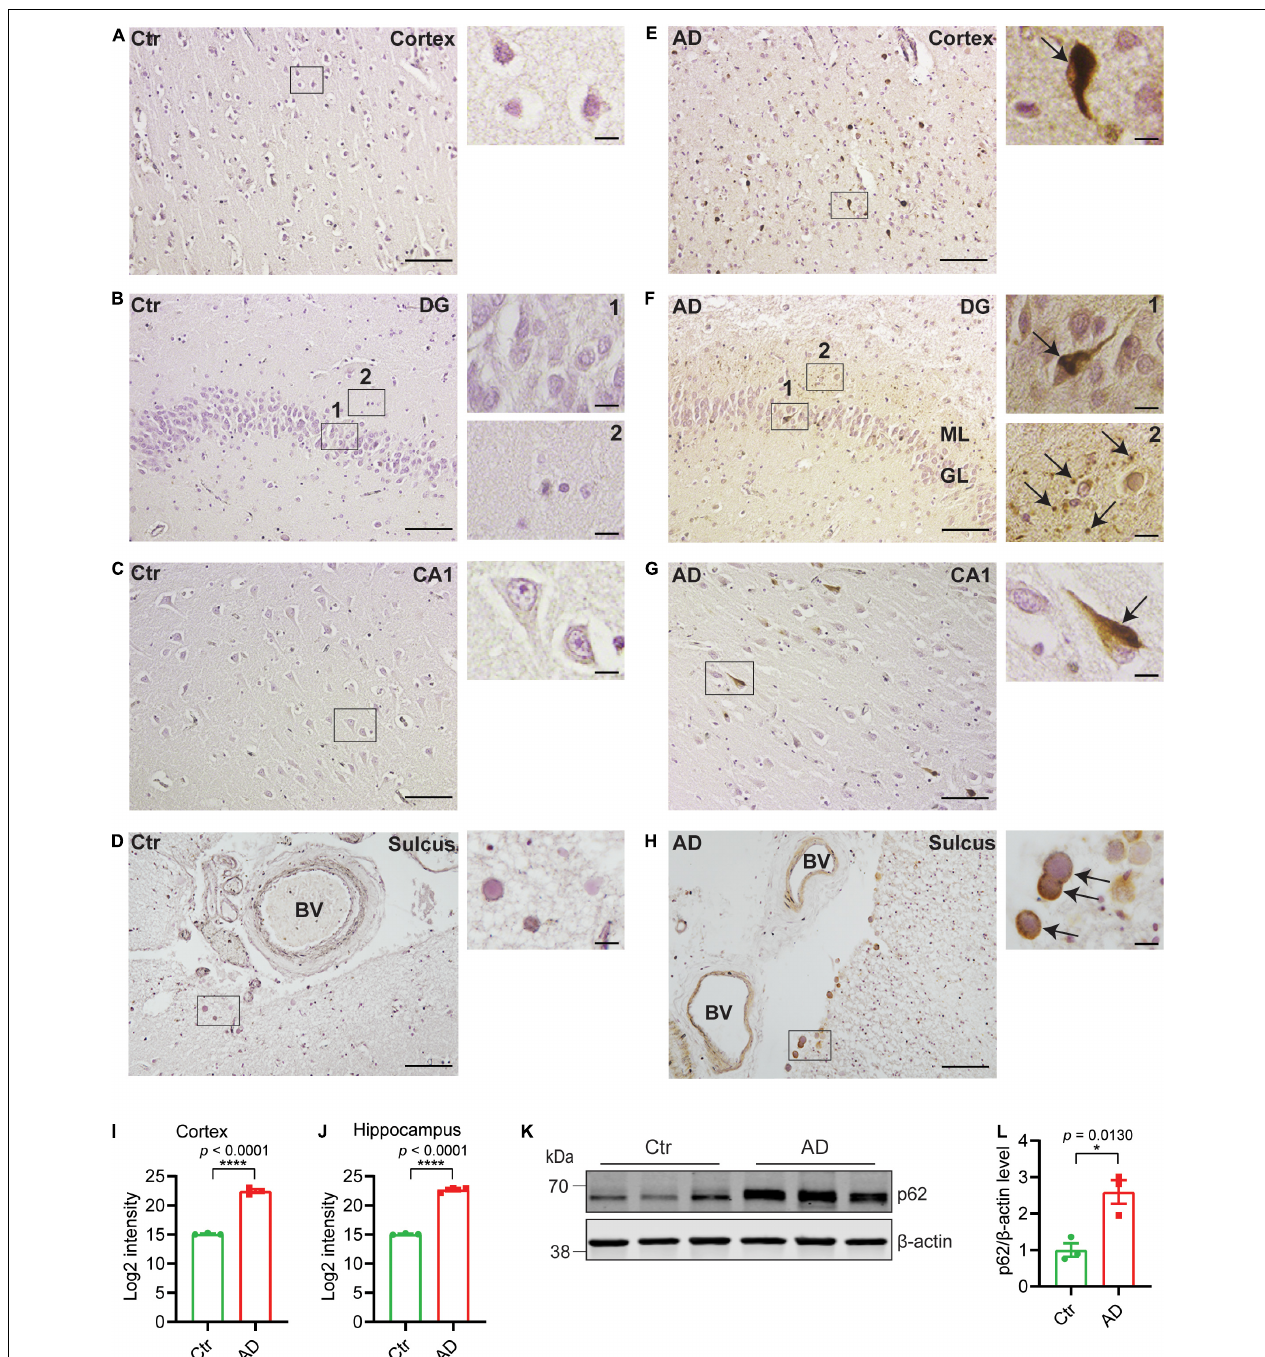
FIGURE 1 | p62 accumulates in AD brains. Immunohistochemistry of p62 in entorhinal cortex, DG, and CA1 of hippocampus and sulcus as indicated from healthy control (Ctr) (A–D) and AD brains (E–H) . Scale bars represent 100 µ m. Higher magnification images of depicted areas (black boxes) are shown to the right. Scale bars represent 10 µ m. Arrows in (E,F1,G) indicate p62 accumulation in neurons of entorhinal cortex and hippocampus; (F2) indicates potential axonal beadings in ML of DG; (H) indicates corpora amylacea. (H) p62 is accumulated in tunica intima of the blood vessels in AD. (I) Semiquantitative density measurement was performed for quantification; 20 × magnification images of six different and separate regions of cortex were chosen from each individual and the intensities were quantified and presented as log2-transformed data. (J) 20 × magnification images of DG, CA1, and CA3 (two for each region) were chosen for hippocampus and the intensities were quantified and presented as log2-transformed data ( n = 3 patients/group, **** p < 0.0001). (K) Western blot analysis of p62 in human postmortem prefrontal cortex from AD and healthy control subjects and (L) quantified by densitometry ( n = 3 patients/group, * p < 0.05). Data were analyzed by Student’s t -test. Data are represented as mean ± SEM. DG, dentate gyrus; BV, blood vessel; ML, molecular layer; GL, granular layer.